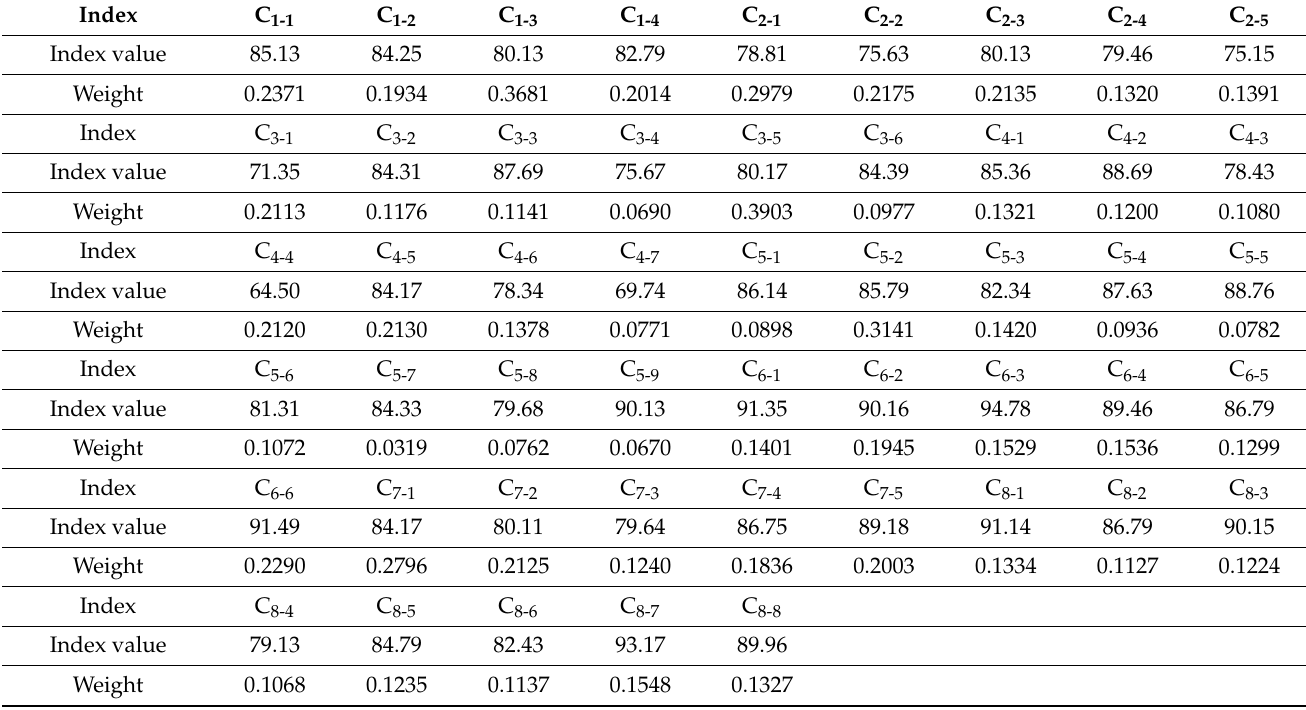
Table 3. Performance evaluation index value and weight of water environment treatment and ecological restoration project in